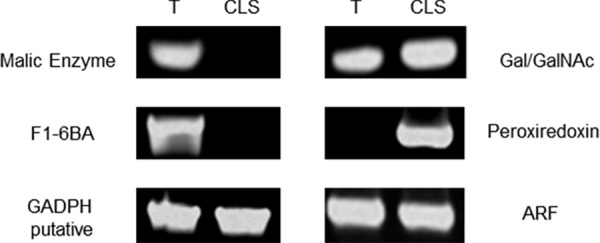
Validation of proteins identified by RT-PCR.Five proteins were selected for RT-PCR validation. Left above: malic enzyme. Left middle: F1-6BA, fructose 1,6-bisphosphate aldolase. Left below: GAPDH: glyceraldehyde 3-phosphate dehydrogenase. Right above: Gal/GalNAc lectin LC3 fragment. Right middle: peroxiredoxin. Right below: ARF, ADP-ribosylation factor, used as loading control. T: trophozoite, CLS: cyst-like structure.